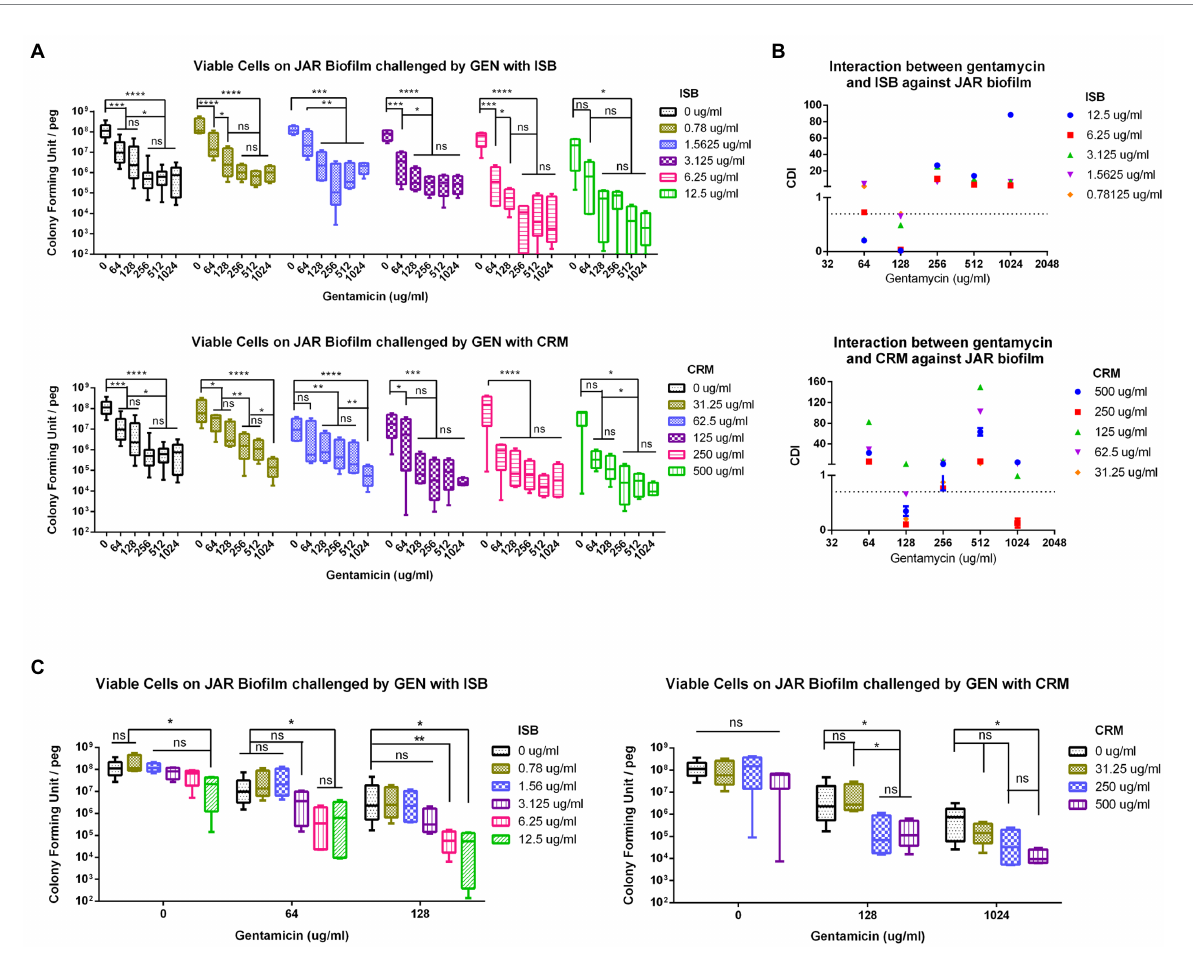
FIGURE 3 Interaction of isobavachalcone and curcumin with Gentamycin against Staphylococcus aureus JAR biofilm. (A) Residual S. aureus JAR on Biofilm challenged by combination of Gentamycin with Isobavachalcone or Curcumin. (B) Coefficient of Drug Interaction (CDI) of the combination of Gentamycin with isobavachalcone or curcumin. (C) Synergistic Combination of isobavachalcone with Gentamycin, and Curcumin with Gentamycin. CDI < 1, =1 or >1 indicate synergy, superposition or antagonism, respectively, CDI < 0.7 indicates significant synergism. Data were presented as mean ± SD. * represents p < 0.05, ** represents p < 0.01, *** represents p < 0.001, **** represents p < 0.001, when compared to ISB/CRM with the same Gentamycin concentration, ns represents no significance. GEN, Gentamycin; ISB, Isobavachalcone; CRM, Curcumin; CDI, Coefficient of Drug